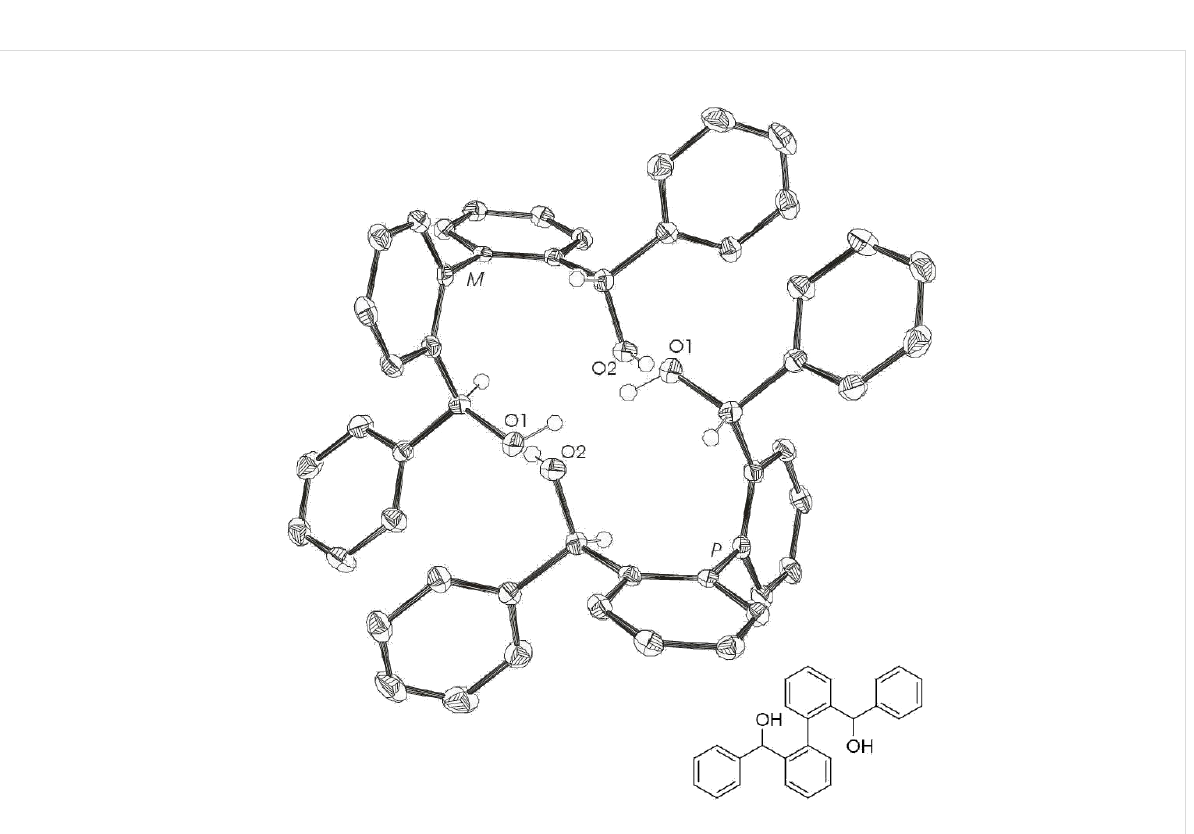
Figure 1: X-ray crystal structure of 6 . ( M ) - ( S,S ) and ( P ) - ( R,R ) pair of enantiomers; intermolecular O1–O2 distance 2.81 Å; intramolecular O1–O2 dis- tance 2.83 Å. Ellipsoids correspond to 50% probability levels. Hydrogen atoms are omitted for